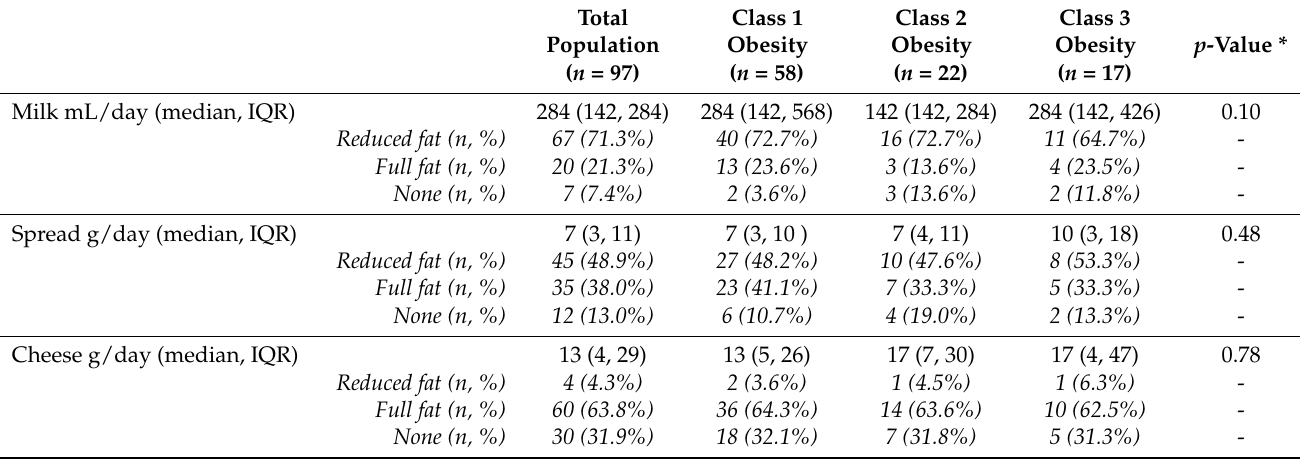
Table 3. Diet patterns for the total population, and stratified by obesity